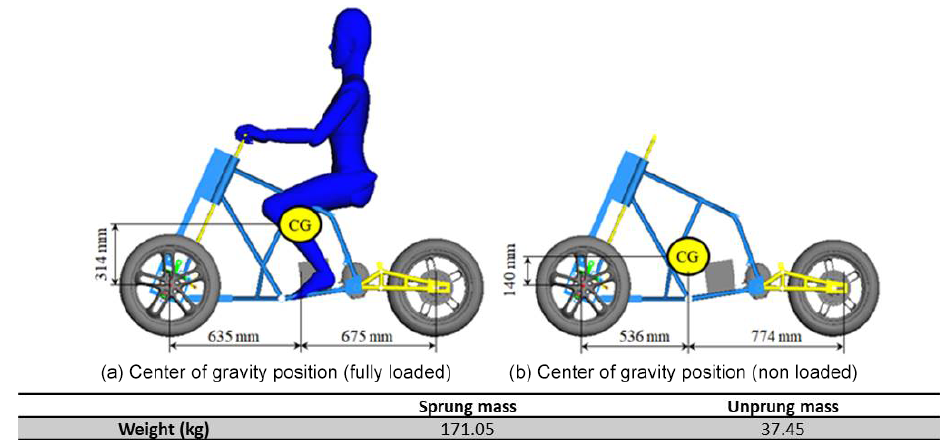
Figure 4. Center of gravity position of the vehicle.